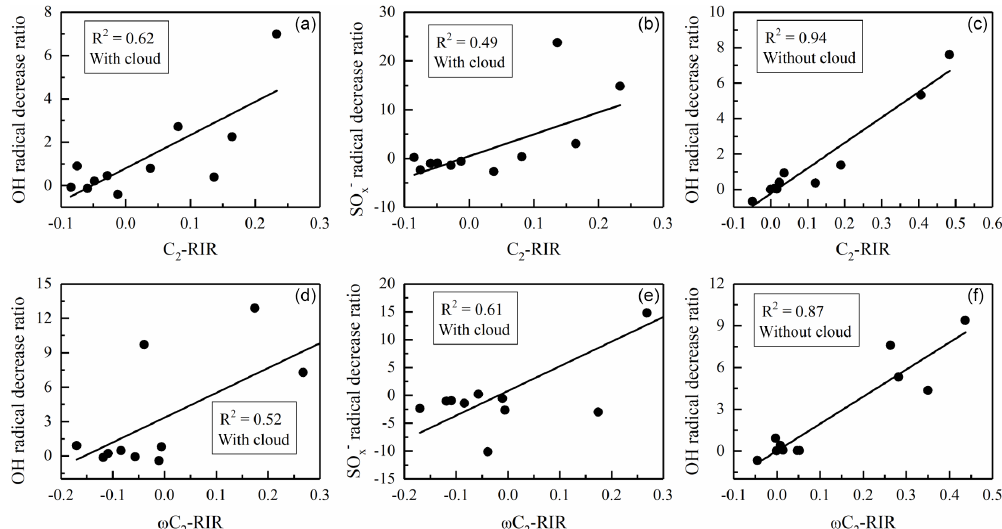
Figure 9. Correlations between the decreasing ratios of radical oxidants and C 2 -RIR (a, b, c) and ω C 2 -RIR (d, e, f) under C2w and C2wo conditions, respectively.